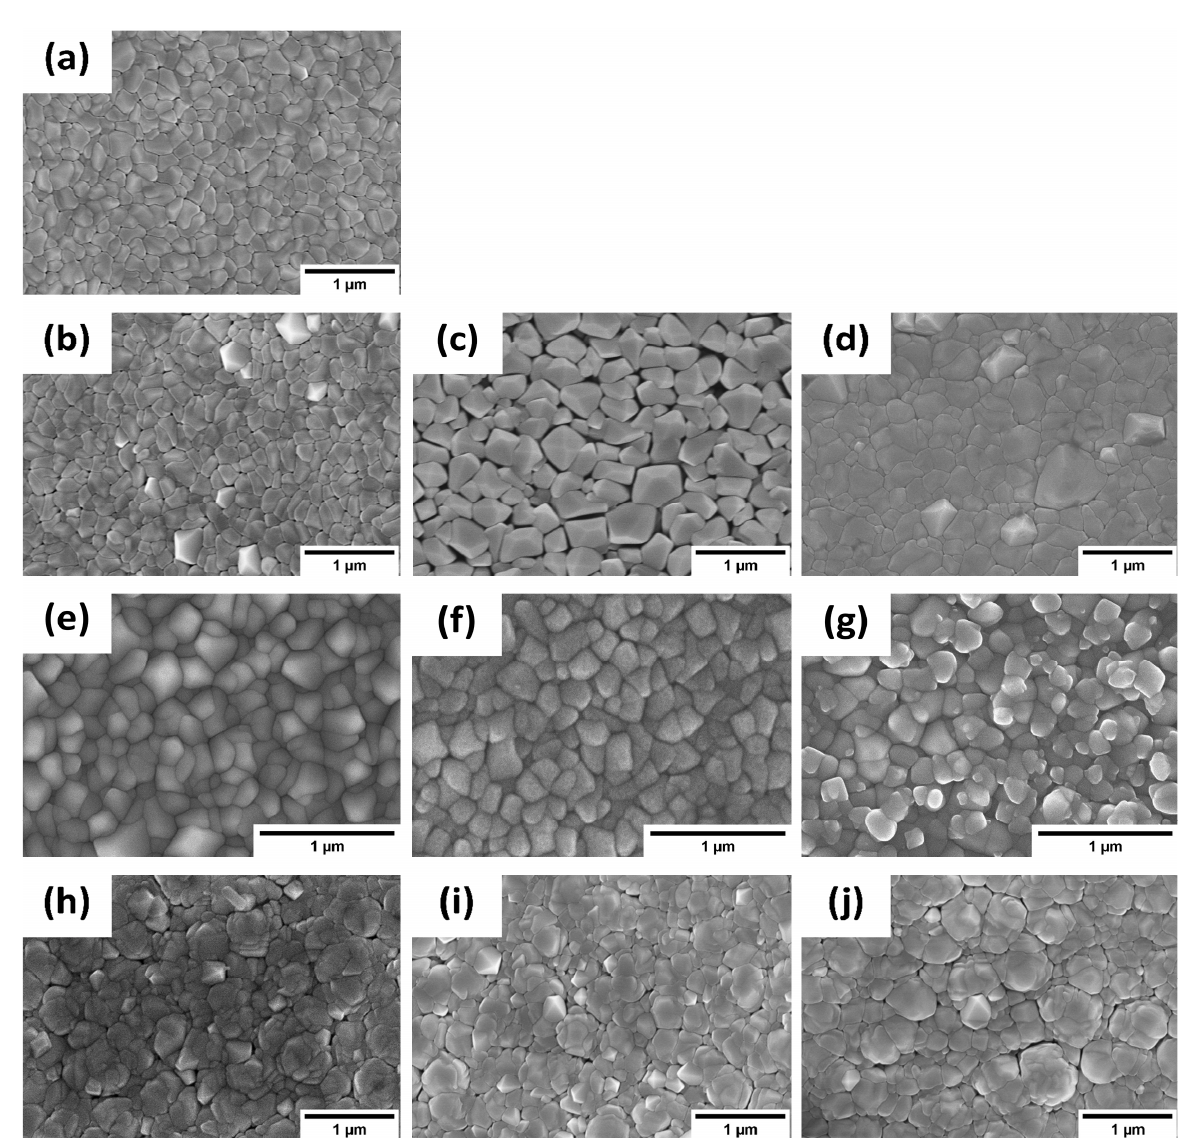
Figure 2. SEM surface images of ( a ) AlZr, ( b ) Al 2 O 3 /AlZr, ( c ) ZnO/AlZr, ( d ) TiO 2 /AlZr, ( e ) AlZr/Al 2 O 3 , ( f ) AlZr/ZnO, ( g ) AlZr/TiO 2 , ( h ) AlZr/Al 2 O 3 /AlZr, ( i ) AlZr/ZnO/AlZr, and ( j ) AlZr/TiO 2 /AlZr.